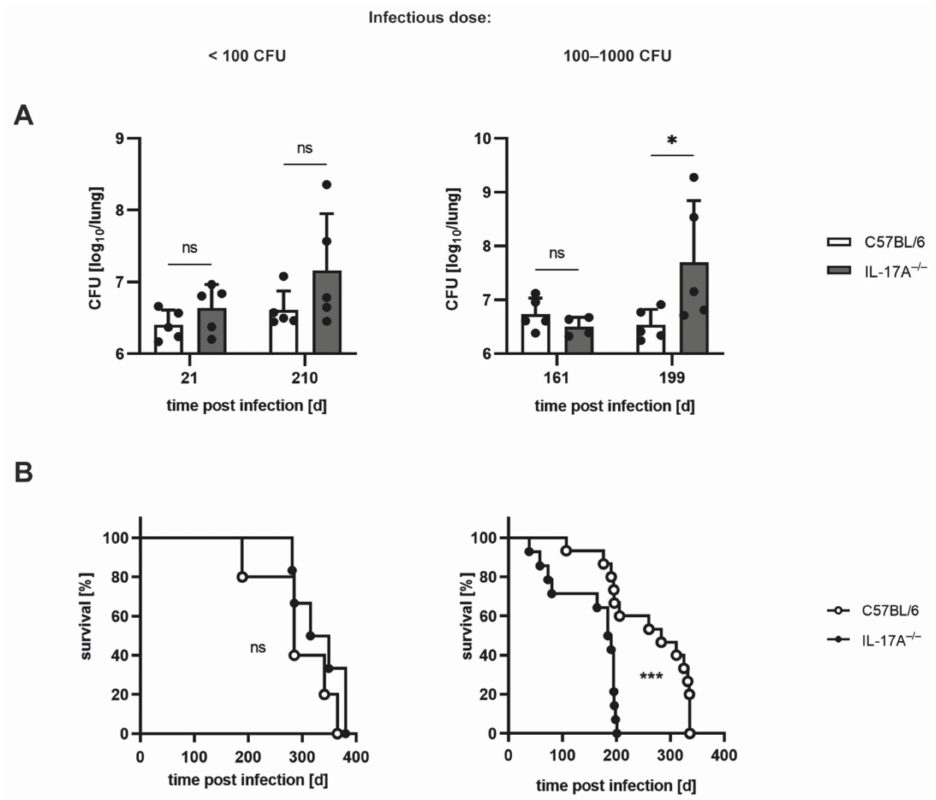
Figure 1. After infection with elevated doses of Mtb, IL-17A − / − mice exhibit impaired control of mycobacterial growth and accelerated death. ( A , B ) C57BL/6 and IL-17A − / − mice were infected with <100 CFU (left) or 100–1000 CFU (right) of H37rv Mtb by an aerosol. ( A ) At different time points of infection, CFUs in the lungs were determined. Data are presented as single dots and as the mean ± SD of 4–5 mice per group from one representative experiment (100–1000 CFU) or from one representative experiment out of two performed (<100 CFU). Statistics were calculated for log-transformed data using a two-way ANOVA with Bonferroni’s post hoc test. Differences between C57BL/6 and IL-17A − / − mice were defined as significant (ns p ≥ 0.05; * p < 0.05). ( B ) The survival of 5–15 mice per group was recorded using humane endpoints. Statistical analysis was accomplished using the log-rank test. Differences in the survival kinetics between C57BL/6 and IL-17A − / − mice were defined as significant (ns p ≥ 0.05; *** p <